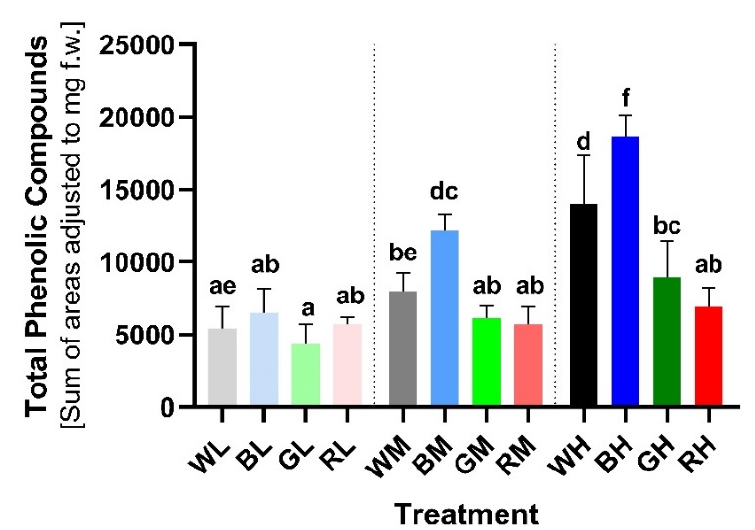
Figure 3. Total PheC content in secondary leaves of Hordeum vulgare L. cv. Bojos acclimated to light conditions varying in irradiance and spectral qualities. W (white), B (blue), R (red), G (green), L (low irradiance, 100 µ mol m − 2 s − 1 ), M (medium irradiance, 200 µ mol m − 2 s − 1 ), and H (high irradiance, 400 µ mol m − 2 s − 1 ), n = 5–6 ± SD. The total content of soluble PheCs was evaluated based on HPLC-DAD data as a sum of peak areas (detected at 314 nm) and adjusted to the FW of each sample (for more details, see Section 4.4). Treatments marked above with same letters did not significantly differ based on Tukey’s post-hoc